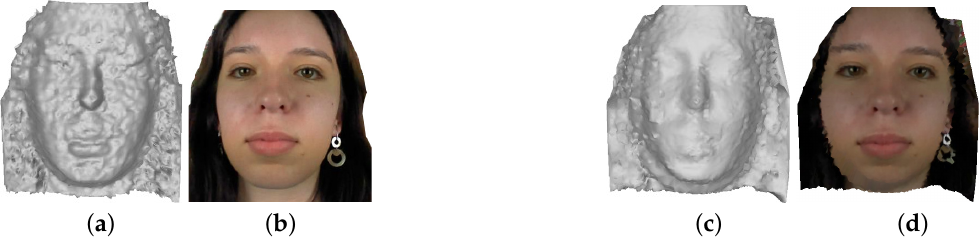
Figure 17. The correction of a mesh obtained using DepthSense camera [43]. We first standardized the scale and sampling frequency in relation to the database, and then we corrected using our filter. Figure ( a ) shows the acquired noisy mesh, ( b ) is only the texture, ( c ) is the filtered mesh and ( d ) is the filtered mesh with texture.